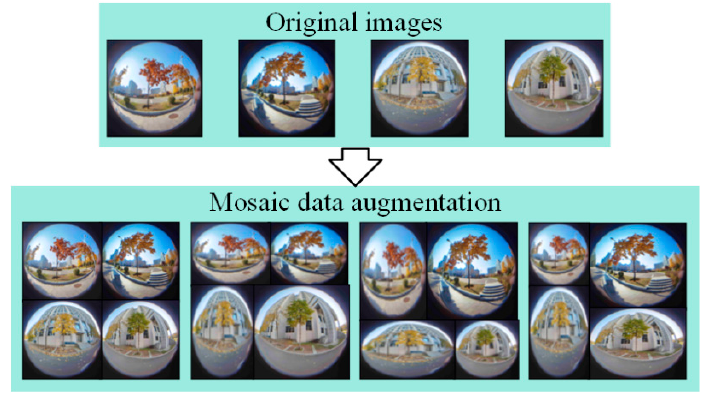
Figure 5. Mosaic data augmentation.